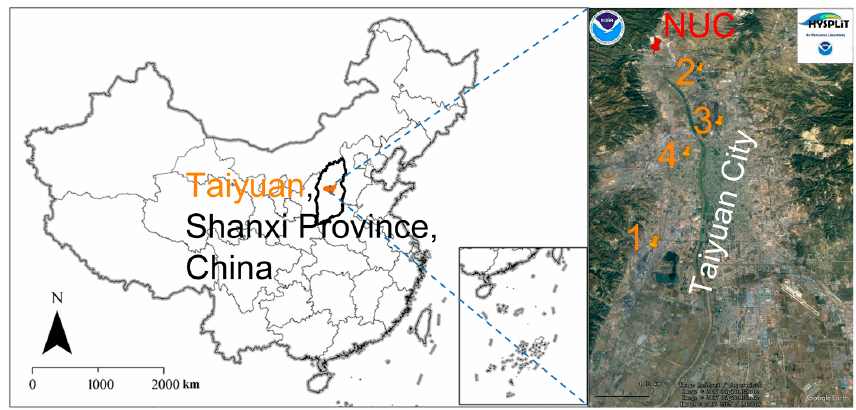
Figure 1. Sampling site and the main industries (NUC represents the sampling site at the North University of China; 1, 2, 3, and 4 are the First and Second Power Stations, Taiyuan Iron and Steel Factory, and Taiyuan Heavy Machinery Factory, respectively).